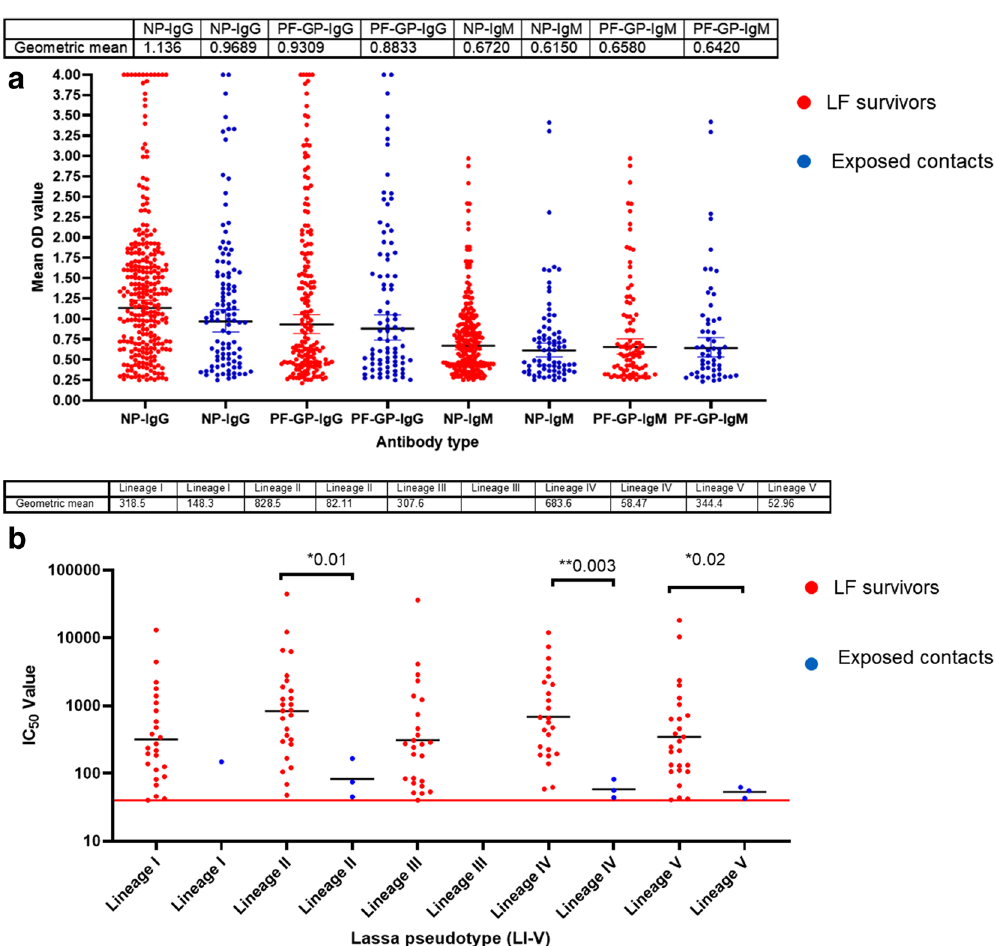
Figure 2. Binding antibody responses (IgG and IgM) to LASV GP and NP proteins ( a ) and neutralizing antibody response to LASV PVs (Lineages I-V) ( b ) from LF survivors and their contacts in Southern Nigeria. Specific Lassa GP and NP ELISA was used to measure the binding antibody response (IgG and IgM) from LF survivors (N = 370) and their contacts (N = 170). We used a 1:100 dilution of the serum sample. Among those with a binding antibody response, we selected some sera from LF survivors and their contacts and measured the neutralizing titre (IC 50 ) against LASV PV expressing the LASV GPC of different lineages ((Lineages I–V). The OD of the negative cutoff was selected as the mean multiplied by three standard deviations of three known negative samples (0.25) for binding antibody and 40 for neutralizing antibody response (the limit of detection). The table shows geometric mean at 95% CI. Statistical significance was calculated by Mann–Whitney test and p values are indicated. (Capped line with * indicating